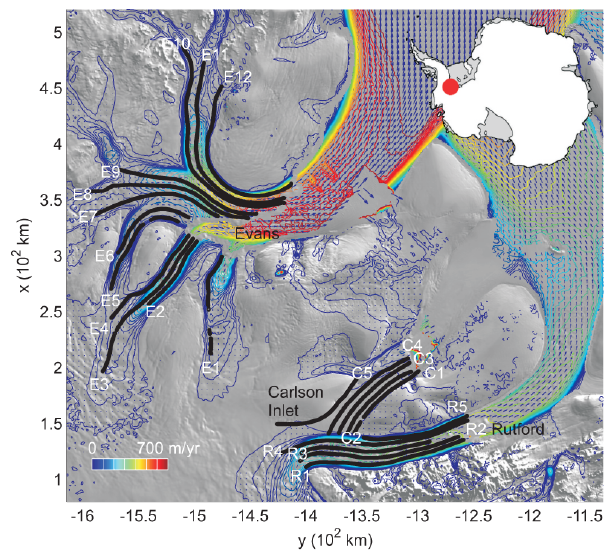
Fig. 2. Map showing the Rutford Ice Stream, Evans Ice Stream and Carlson Inlet which flow into the Filchner-Ronne Ice Shelf (FRIS), West Antarctica (see inset). The colour scale and arrows indicate the InSAR-derived surface velocity field (Rignot et al., 2011) overlaid on a subset of the MODIS mosaic for Antarctica. Only velocities higher than 20myr − 1 are shown. Black lines represent the 22 sec- tions of radar profiles that were analysed in this